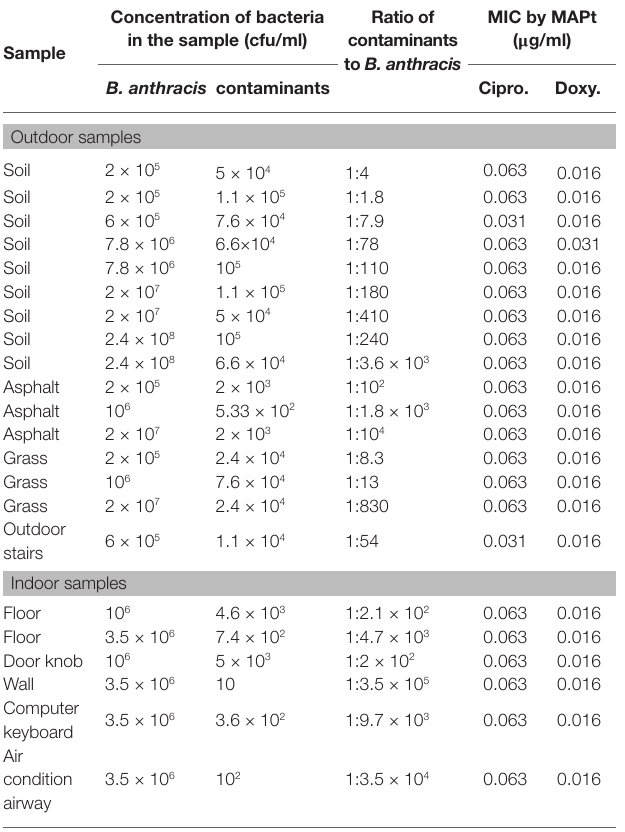
TABLE 1 | MIC values obtained by MAPt for B. anthracis -spiked environmental samples. Concentration of bacteria in the sample (cfu/ml) Sample